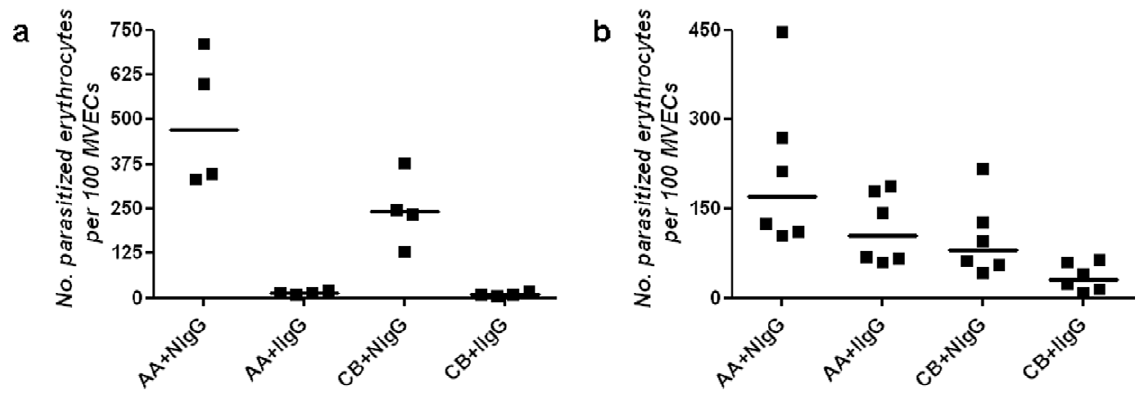
Figure 4. Adherence of parasitized RBCs to MVECs in the presence of immune IgG. The numbers of parasitized AA and CB RBCs adhering to 100 MVECs in the presence of either non-immune or immune IgG are shown. Comparisons were made in parallel using IgG at final concentrations of either 10 mg/mL ( a ) or 0.5–6 mg/mL ( b ). Median values are indicated by horizontal bars. Results were obtained from 2 parasite lines (3D7, FCR-3), multiple blood donors (6AA, 6CB), and 4 endothelial cell lots. For each combination of parasite line and RBC sample tested, the numbers of parasitized RBCs bound to 100 MVECs are shown in Table S2.